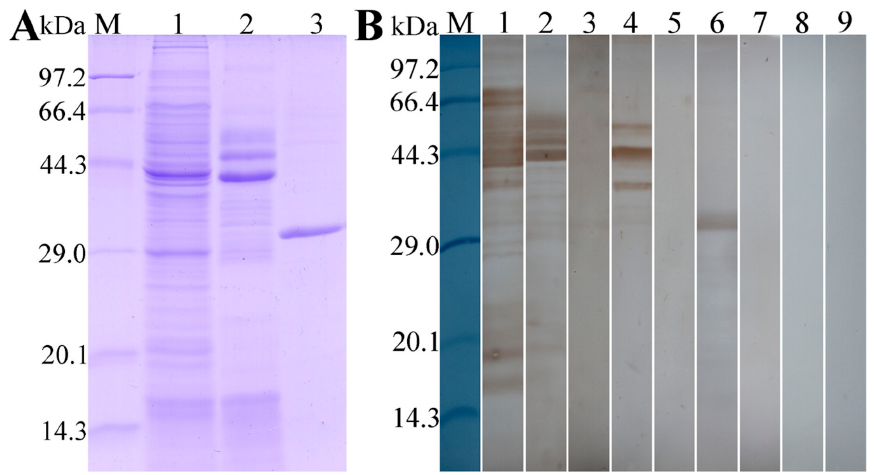
Figure 5. Identification of rTsT antigenicity. ( A ): SDS-PAGE analysis of ML crude antigens (lane 1), ES antigens (lane 2) and purified rTsT (lane 3). ( B ): Identification of rTsT antigenicity on Western blotting. ML crude antigens (lane 1), ES antigens (lane 2) and purified rTsT (lane 3) were probed by